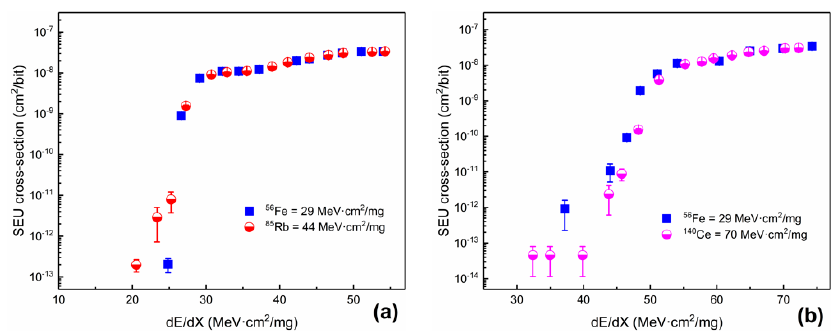
Figure 9. The CS per bit of 3D bulk silicon SRAM as a function of LETs with ( a ) L th = 45 MeV · cm 2 / mg and ( b ) L th = 70 MeV · cm 2 / mg.